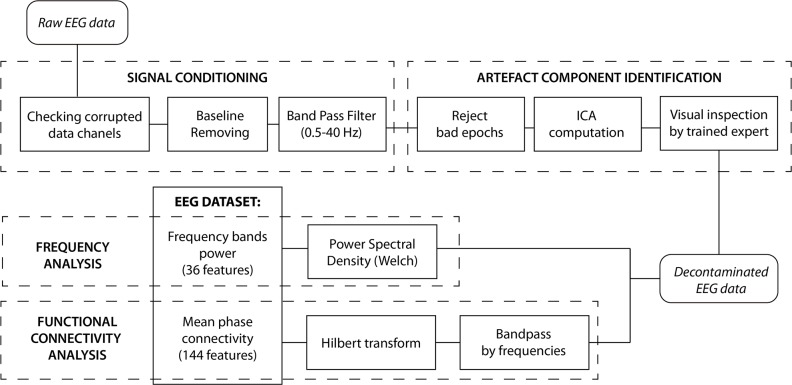
Block scheme of the EEG signal processing steps.